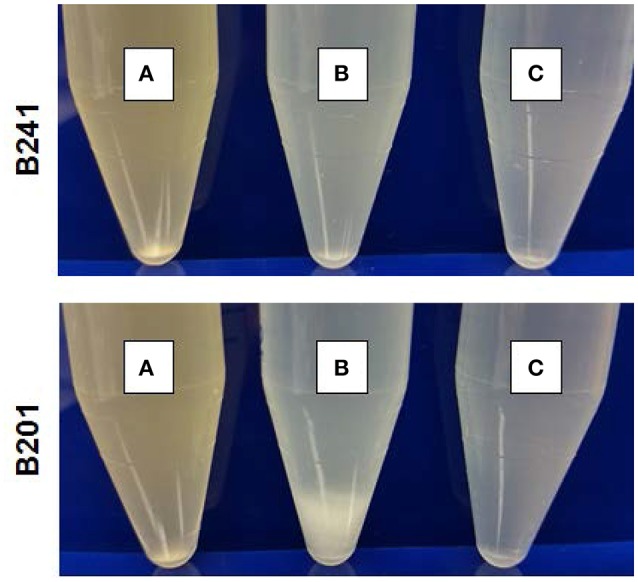
Growth of E. coli O157:H7 PAR strain B241 (top) and FAS strain B201 (bottom) in (A) LBG, (B) M9GT, and (C) M9GT supplemented with 1% glycine. Representative flocculation phenotype is displayed by FAS strain B201 in M9GT whereas flocculation is repressed with glycine supplementation.